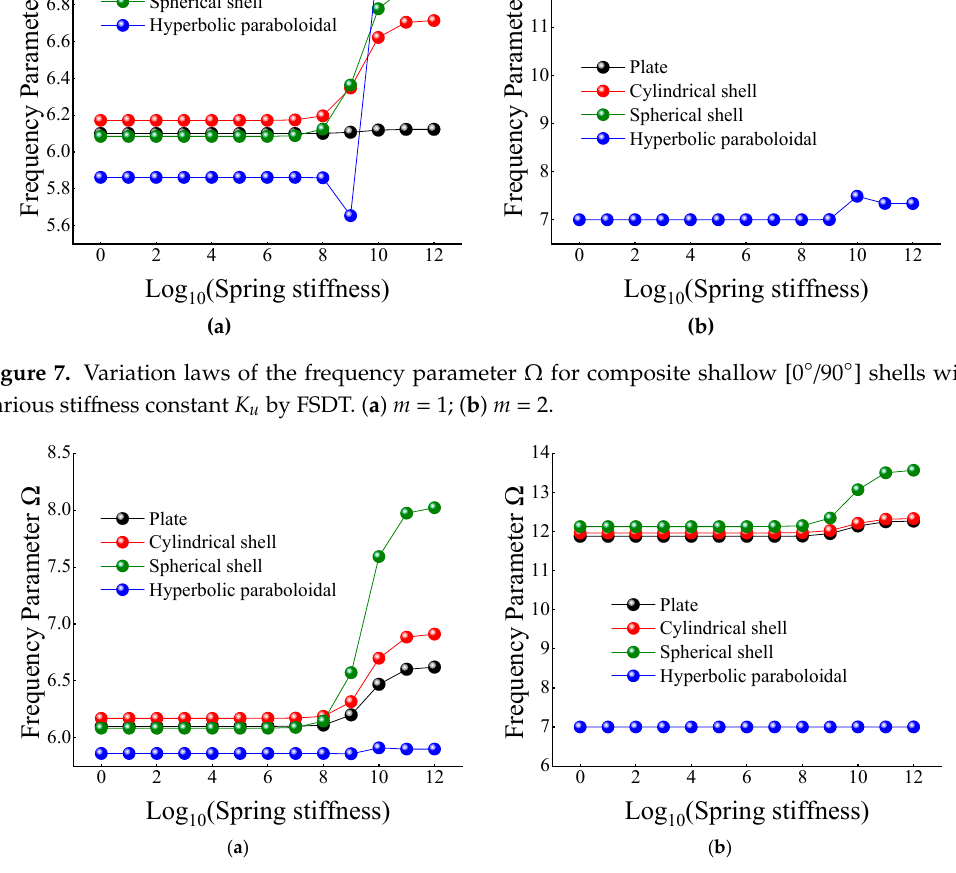
Figure 8. Variation laws of the frequency parameter Ω for composite shallow [0 ° /90 ° ] shells with various stiffness constant K v by FSDT. ( a ) m = 1; ( b ) m = 2.